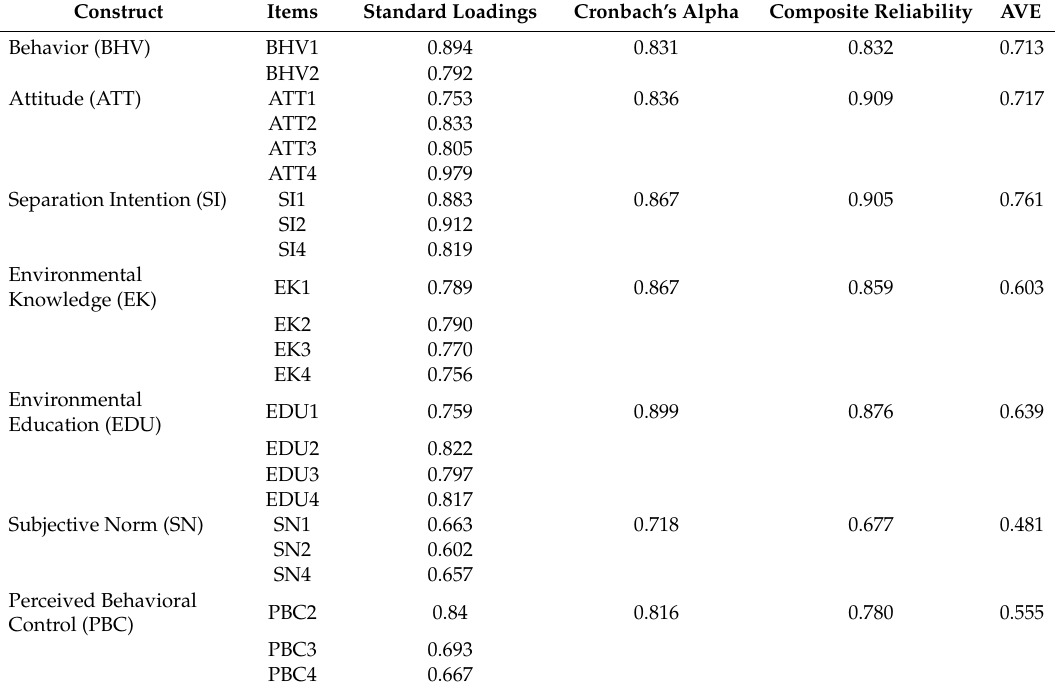
Table 2. Measurement model: reliability and